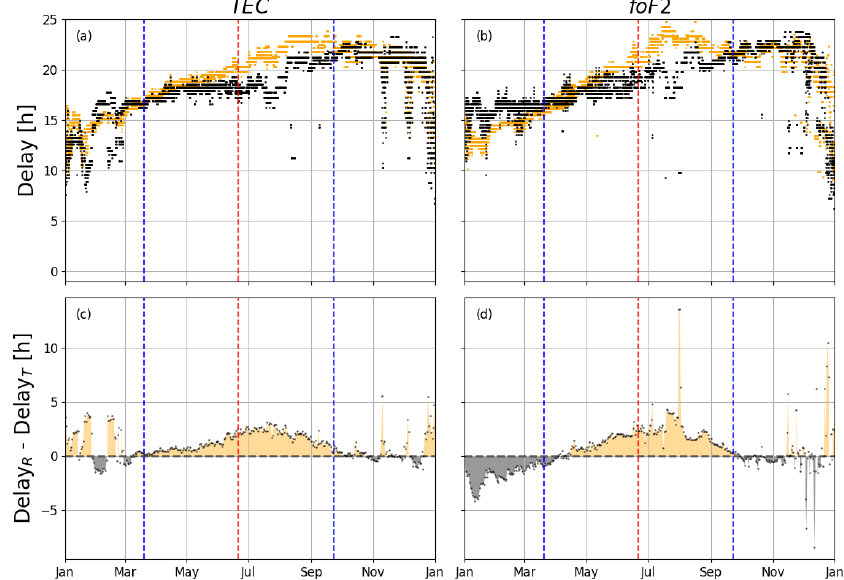
Figure 13. Superposed epoch plots for the delay (a, b) and difference in delays (c, d) for the ionospheric parameters TEC and fo F2 with integrated EVE fluxes (6 to 105nm) for Rome (orange) and Tromsø (black). The temporal resolution is 1h. Equinoxes are marked with the blue dashed lines, and the solstice is marked with the red dashed